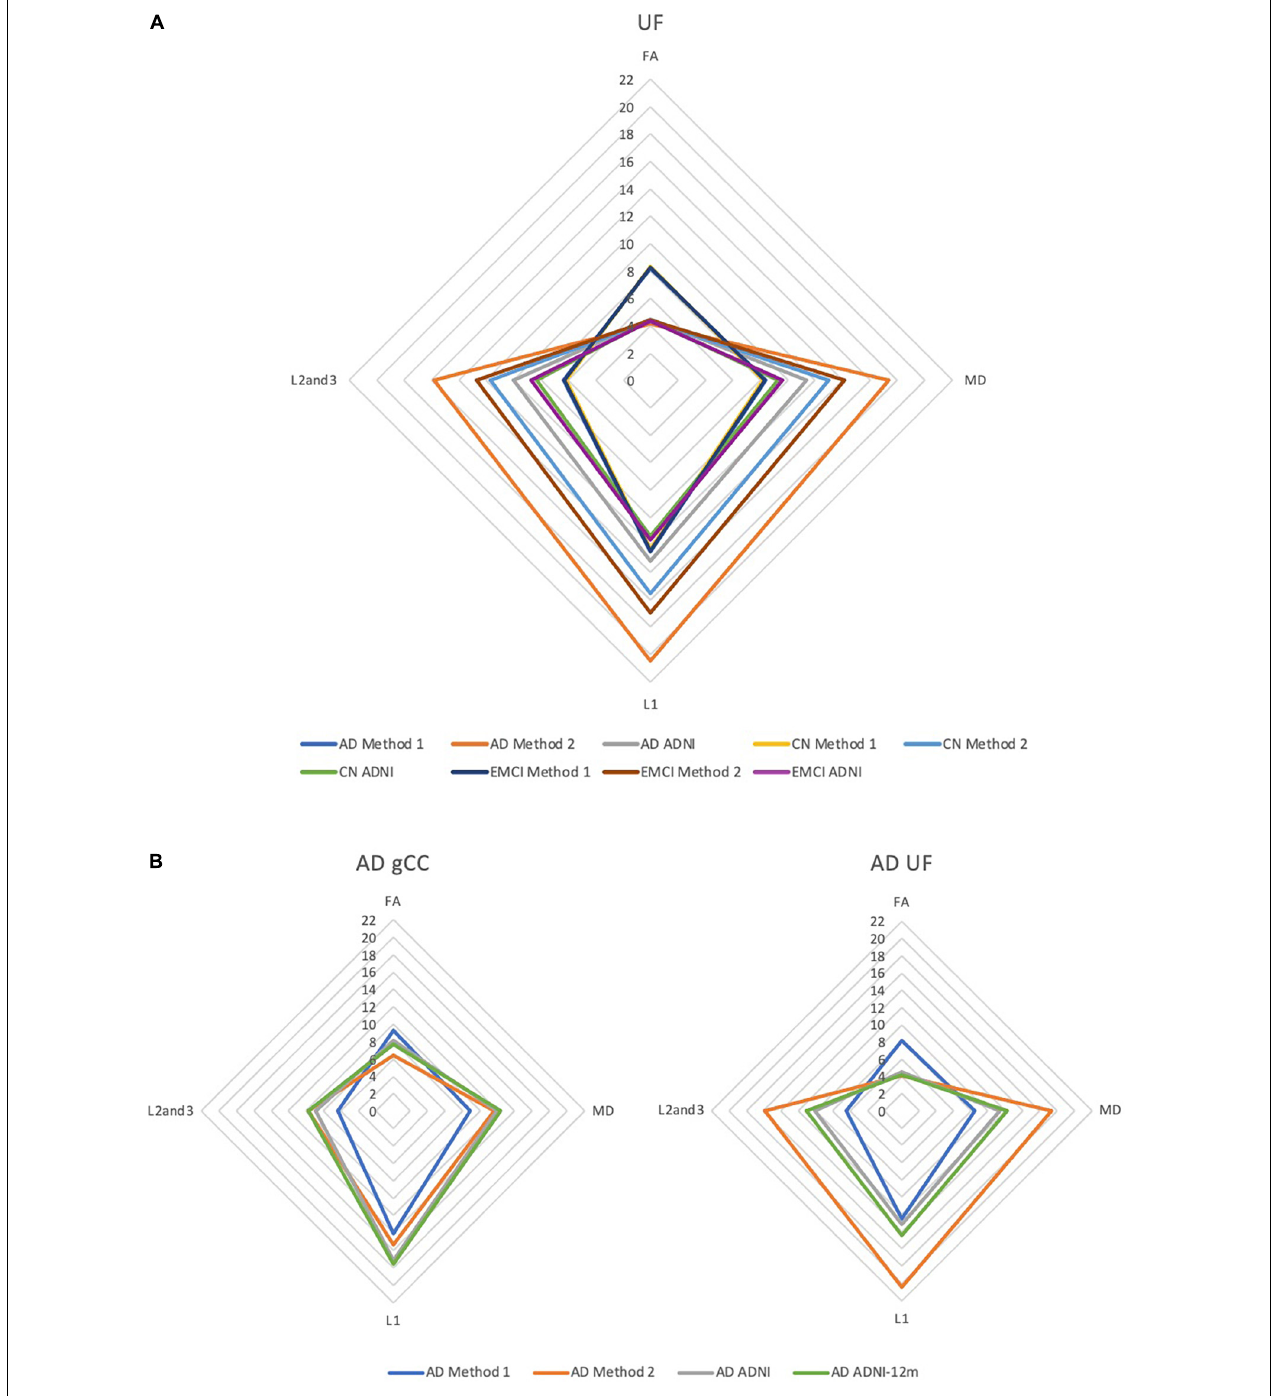
FIGURE 6 | DTI radar graph profiles for comparison of differences in methods vs. (A) cohort differences and (B) changes in the AD cohort after 12 months. DTI metrics from the ADNI data archive are included for reference. FA values are presented as × 20 for illustration; MD, L1, L2, and 3 values are presented as × 10 4 . AD, Alzheimer’s disease; CN, cognitively normal; EMCI, early mild cognitive impairment; gCC, genu of the corpus callosum; UF, uncinate